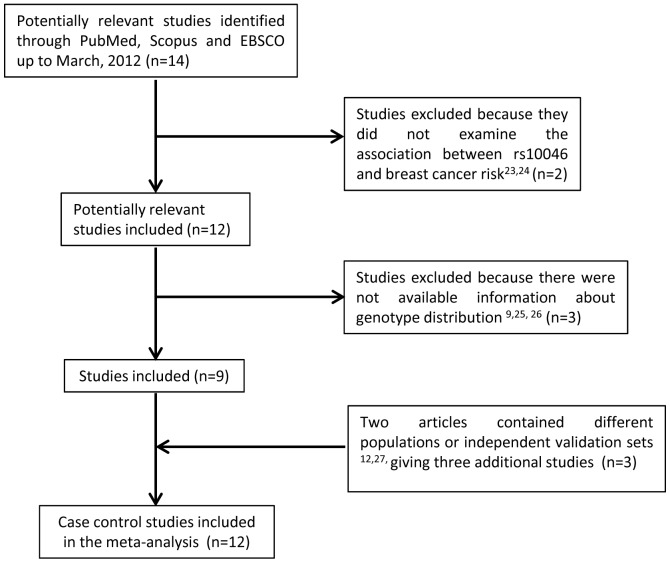
Flow diagram of included/excluded studies.